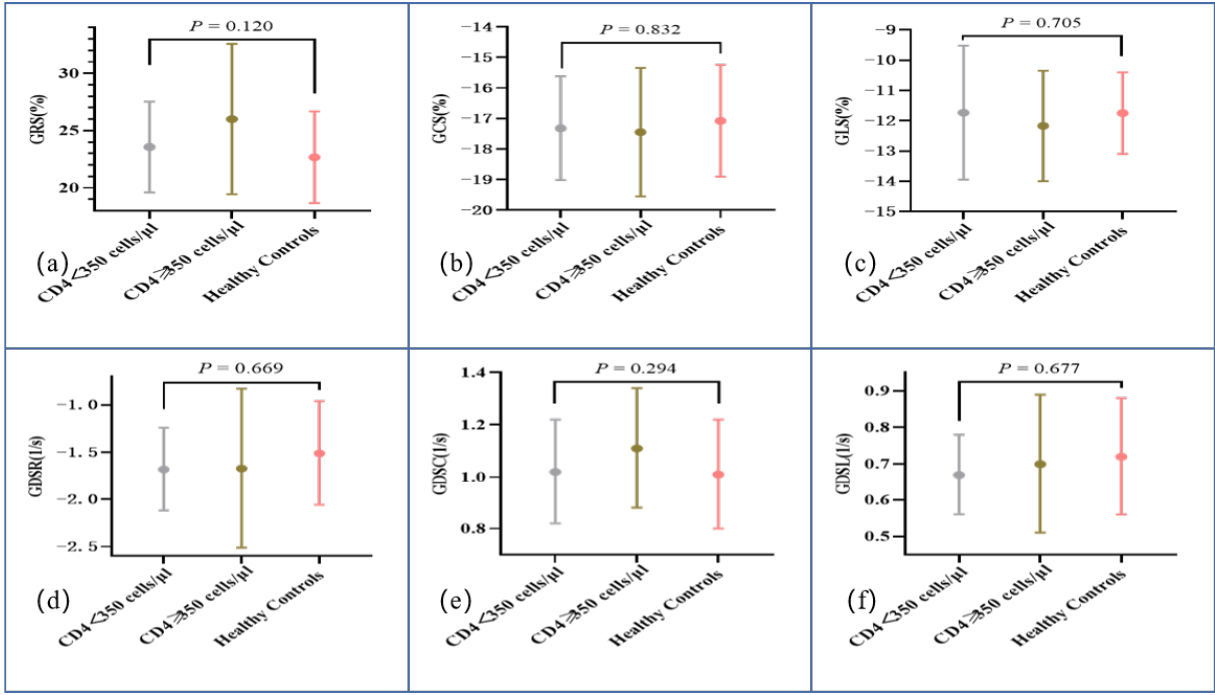
Figure 3. Plots for comparison of left ventricular global radial strain ( a ), global circumferential strain ( b ), global longitudinal strain ( c ), global diastolic strain rate radial ( d ), global diastolic strain rate circumferential ( e ), and global diastolic strain rate longitudinal ( f ). Table 4. Subgroup analysis based on disease